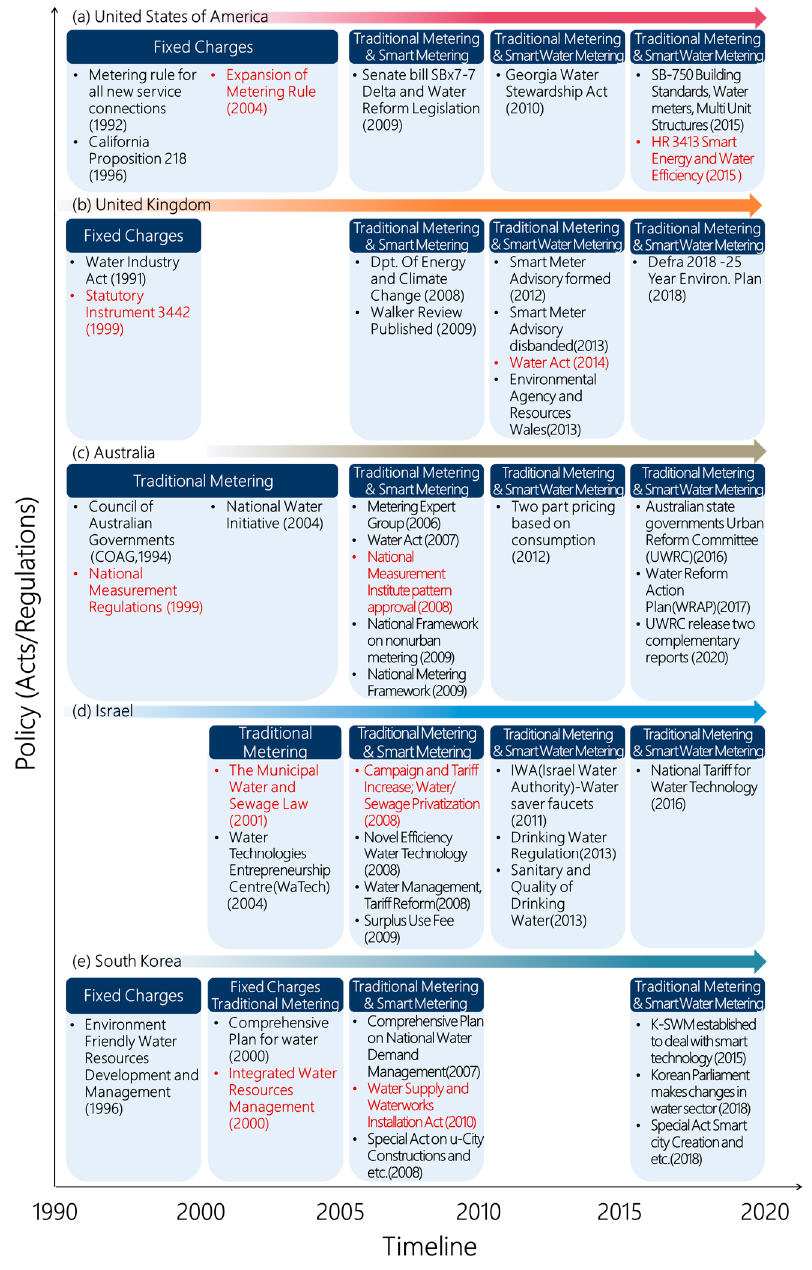
Figure 2. Evolution of water policies regarding tariff and regime of water metering in ( a ) United States of America, ( b ) United Kingdom, ( c ) Australia, ( d ) Israel, and ( e ) South